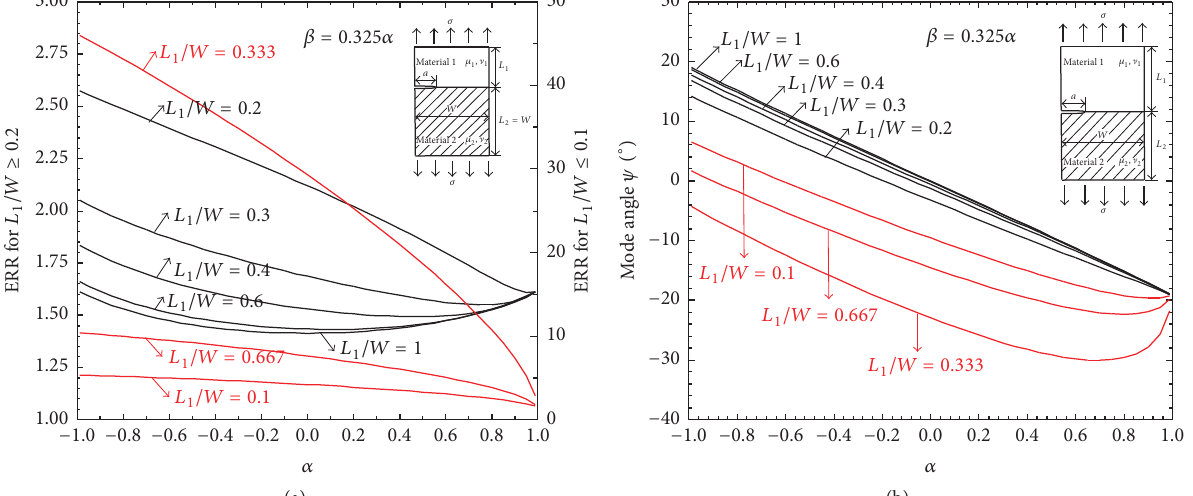
of the asymmetrical models are in red. The effects of the height of the bonded components on ERR and mode